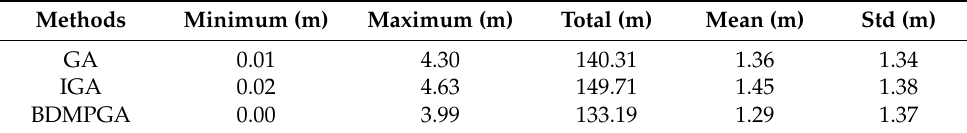
Table 6. Statistics of the displacement distance of each